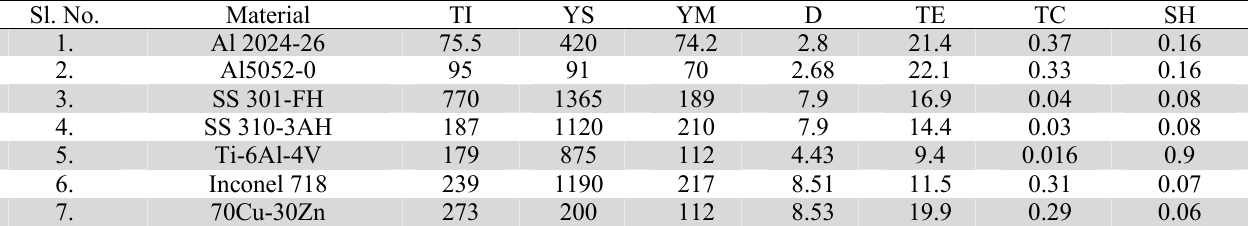
Decision matrix for cryogenic storage tank material selection problem (Dehghan-Manshadi et al., 2007) Sl.